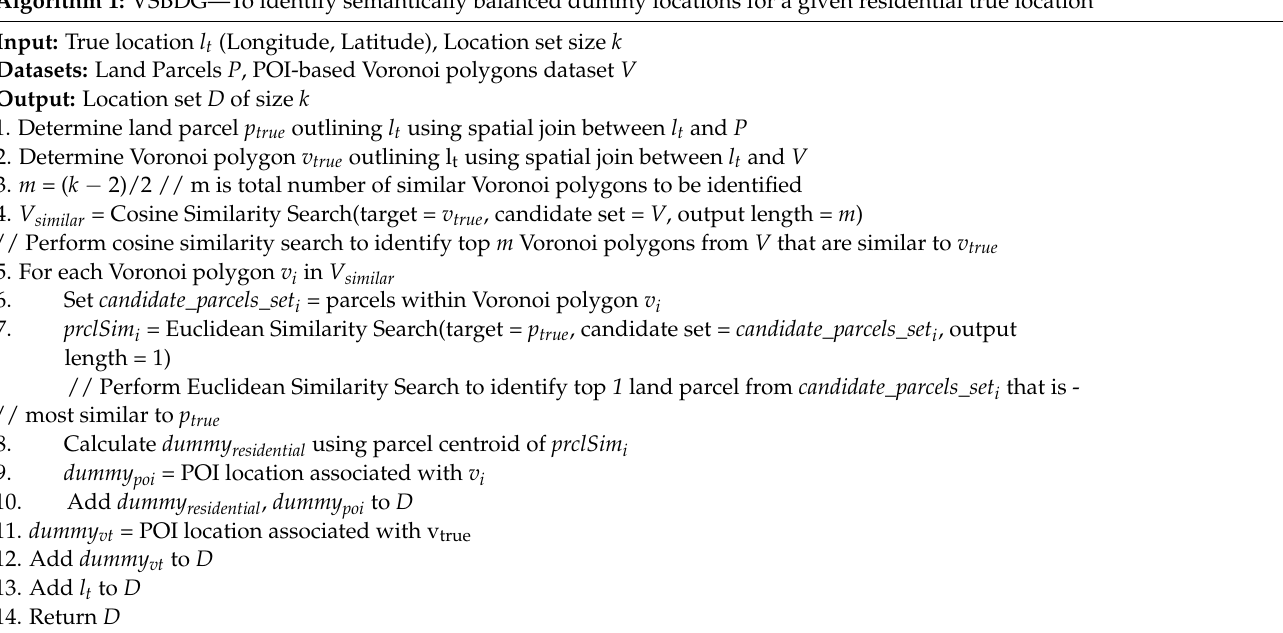
Algorithm 1: VSBDG—To identify semantically balanced dummy locations for a given residential true location